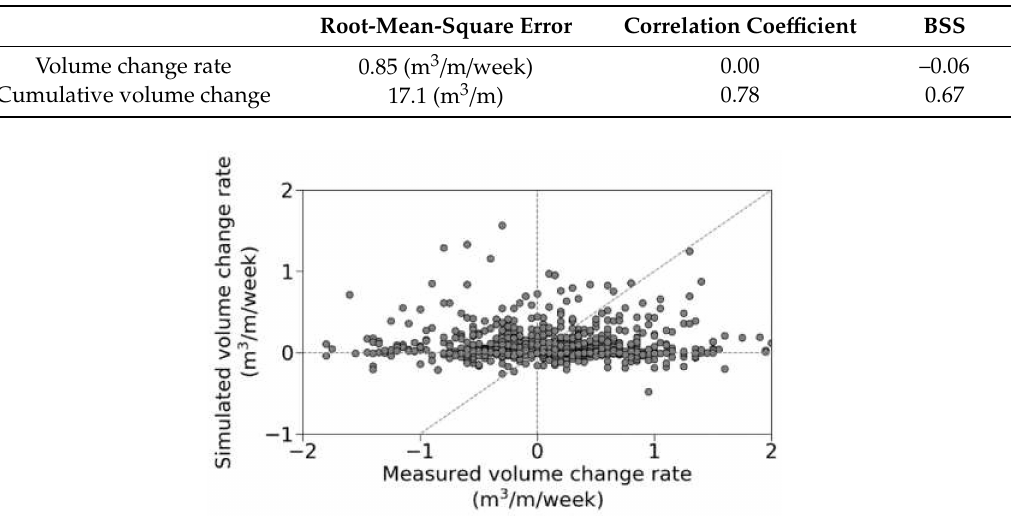
Figure 16. Correlation between the measured and simulated weekly averaged volume-change rates in the validation